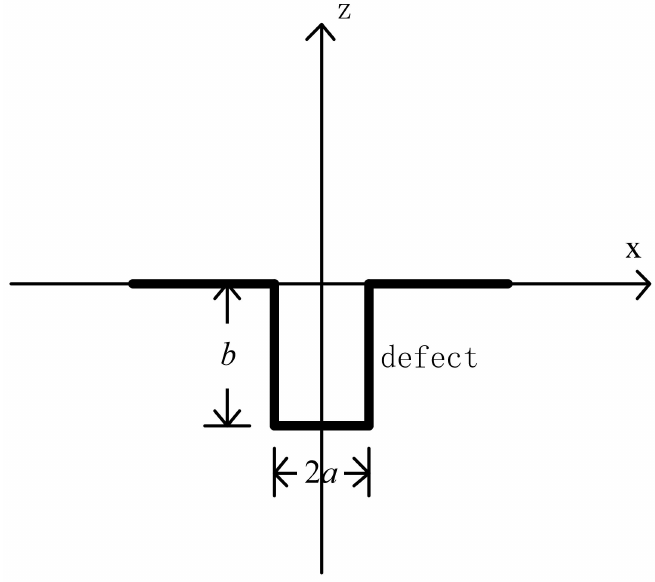
Figure 3. The x and z plane near a defect. According to Equations (1) and (2), if z = 1 mm, a = 1 mm, b = 1 mm, and σ ms = 1, the magnetic field distribution in x and z directions of the defect is shown in Figure 4.